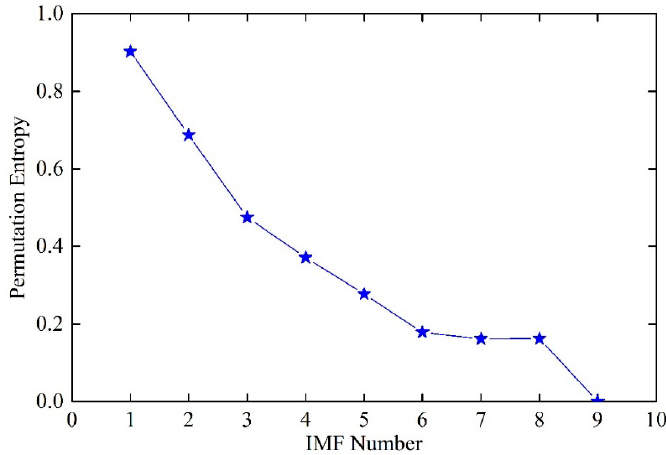
Figure 5. The decomposed results of the original SDI series.